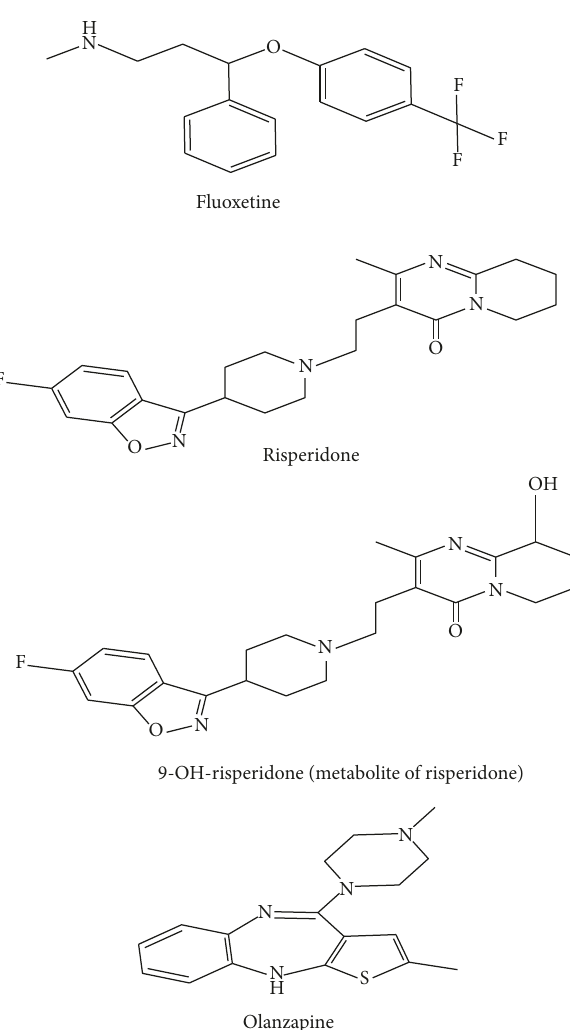
Figure 1: Chemical structure of fluoxetine, risperidone, 9-OH-risperidone, and